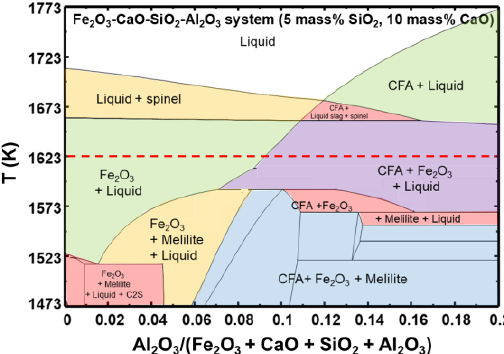
Figure 5. Quaternary phase diagram of Fe 2 O 3 -CaO-SiO 2 -Al 2 O 3 with 5 mass% SiO 2 and 10 mass% CaO calculated by Factsage 8.0.